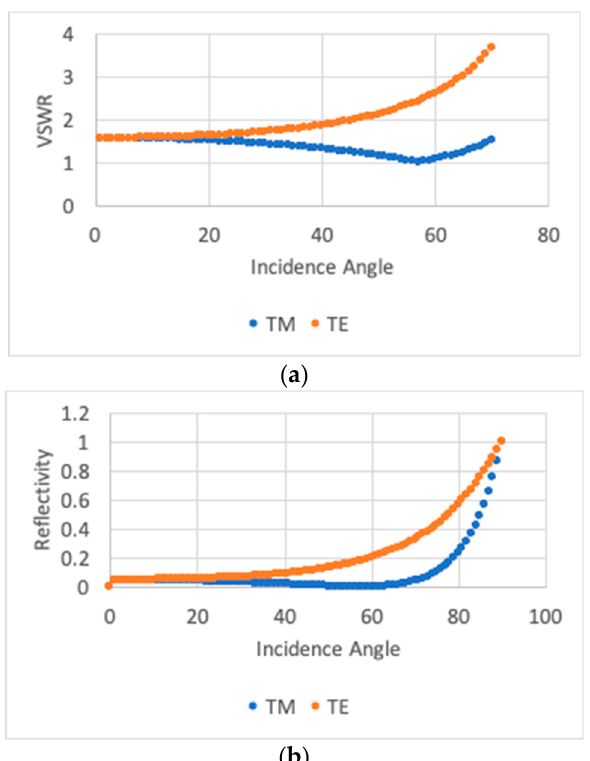
Figure 3. ( a ) VSWR for TE and TM polarizations in the UV region at the air–keratin interface. VSWR, which is measured from one to five, is higher than one for all incidence angles in the case of TE polarization. At the resonance frequency, the VSWR is close to one, corresponding to Brewster’s angle condition or equivalently zero reflectivity for TM polarization. ( b ). Reflectivity spectrum for TE and TM polarizations in the UV region at the air–keratin interface. We can observe that both graphs displayed correlate with each other.